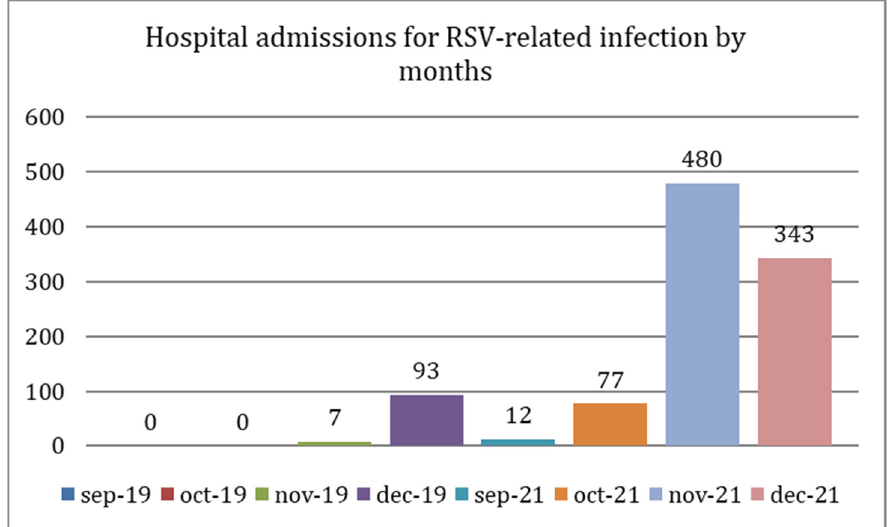
Figure 1. Hospital admissions for RSV-related infection by months (September-December) in 2019 and 2021: in 2019, the peak was recorded in December, while in 2021, the peak was recorded in November. Considering only children tested at the major regional Pediatric Hospital and Coordi- results showed that in 2019, 20.0% of the children tested for RSV were positive, compared to 57.6% in 2021. Weekly test results for RSV, influenza and SARS-CoV-2 during the study periods of these two years are shown in Figure